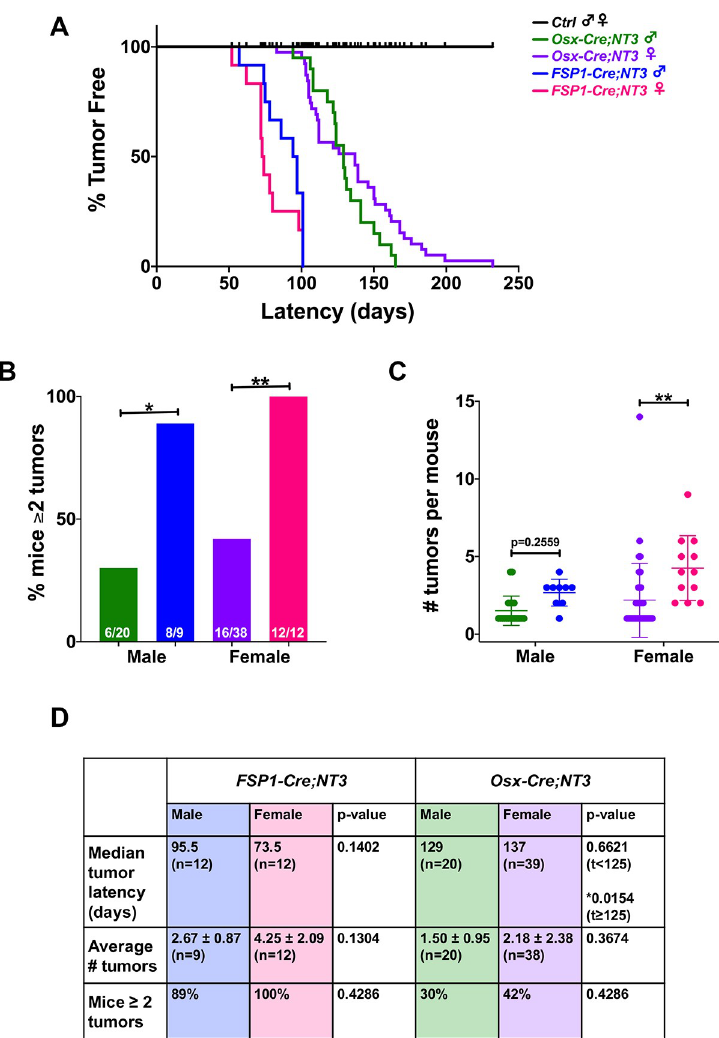
Fig 1. NT3 transgenic mice develop spontaneous soft tissue tumors. (A) Kaplan-Meier curves showing tumor latency by sex in each strain. (B) Comparison between strains of males or females for the percentage of mice with � 2 tumors or (C) number of tumors per mouse. (D) Comparison by sex of the median tumor latency, average number of tumors per mouse, and percentage of mice with � 2 tumors in Osx-Cre;NT3 and FSP1-Cre;NT3 . Sample sizes are as indicated. Results are presented as mean ± SD. Standard log-rank (Mantel-Cox) test or extended (time-varying) Cox proportional hazards model for Kaplan-Meier curves. Two-way ANOVA followed by Sidak’s multiple comparisons test for numbers of tumors per mouse or Fisher’s exact test with FDR adjustment for percentage of mice with � 2 tumors. � p < 0 . 05 , �� p < 0 . 01 .